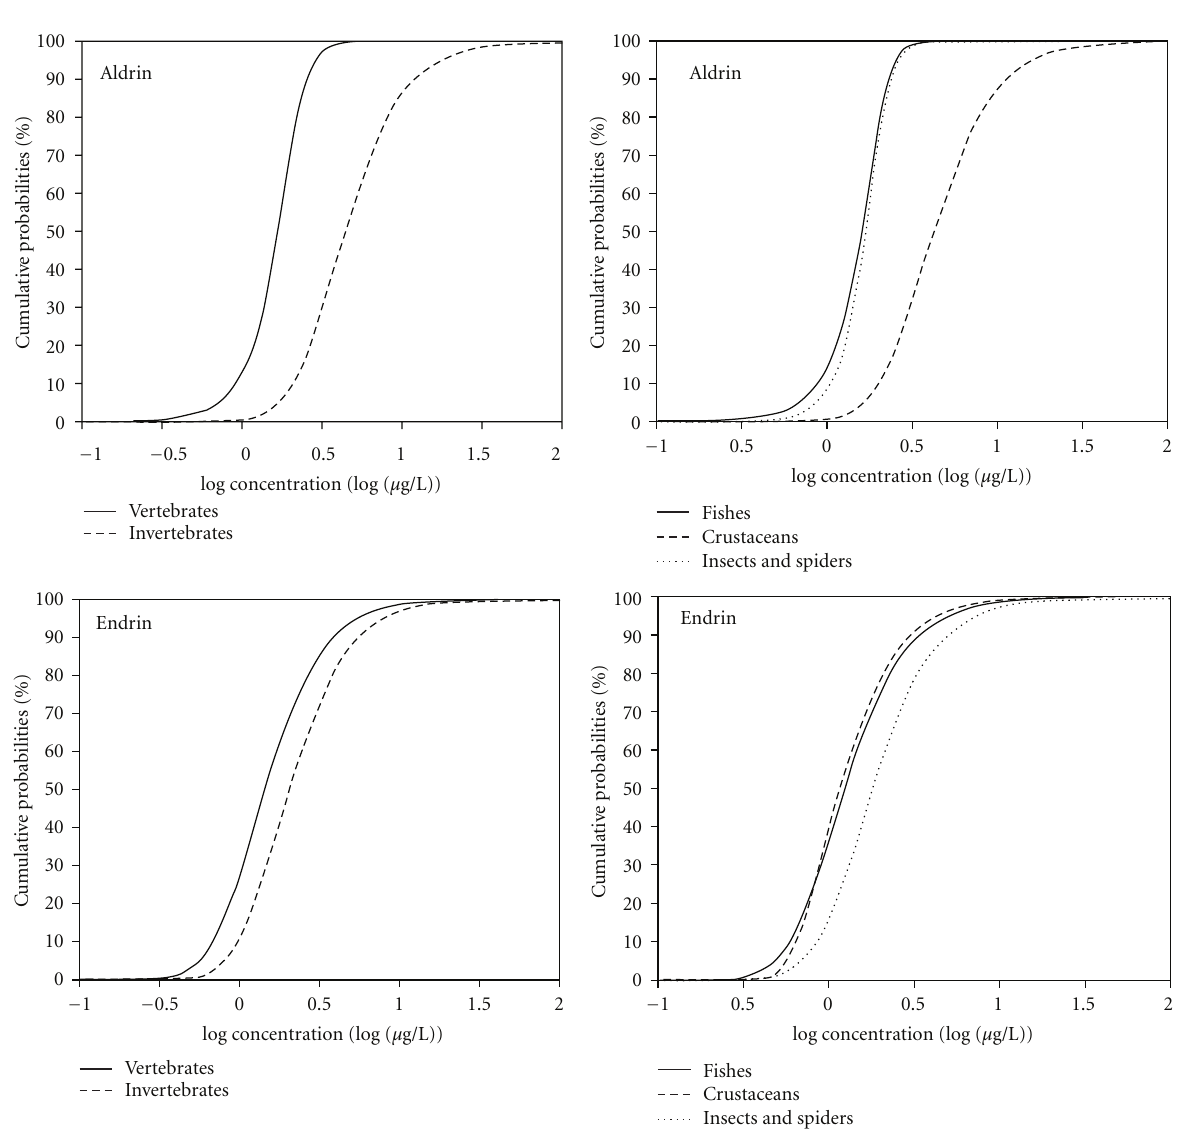
Figure 2: The SSD curves of typical OCPs for di ff erent